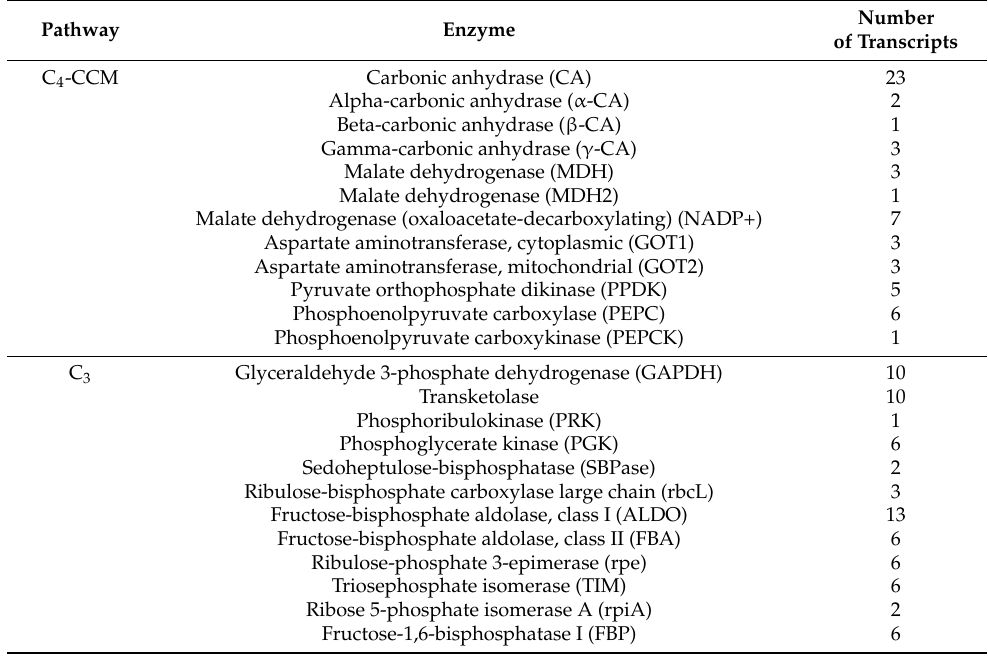
Table 2. Transcripts involved in inorganic carbon fixation that were identified in Kappaphycus alvarezii .